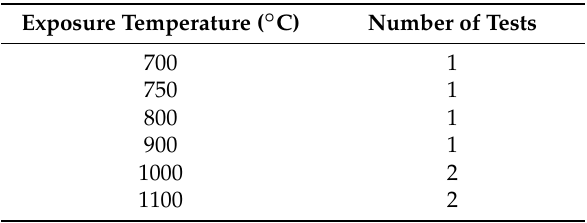
Table 1. Holding temperature and number of exposure tests.